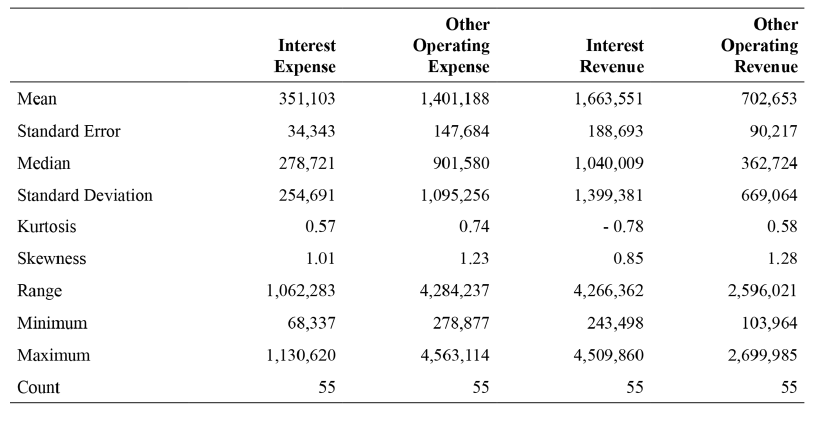
Figure A1. Summary statistics.